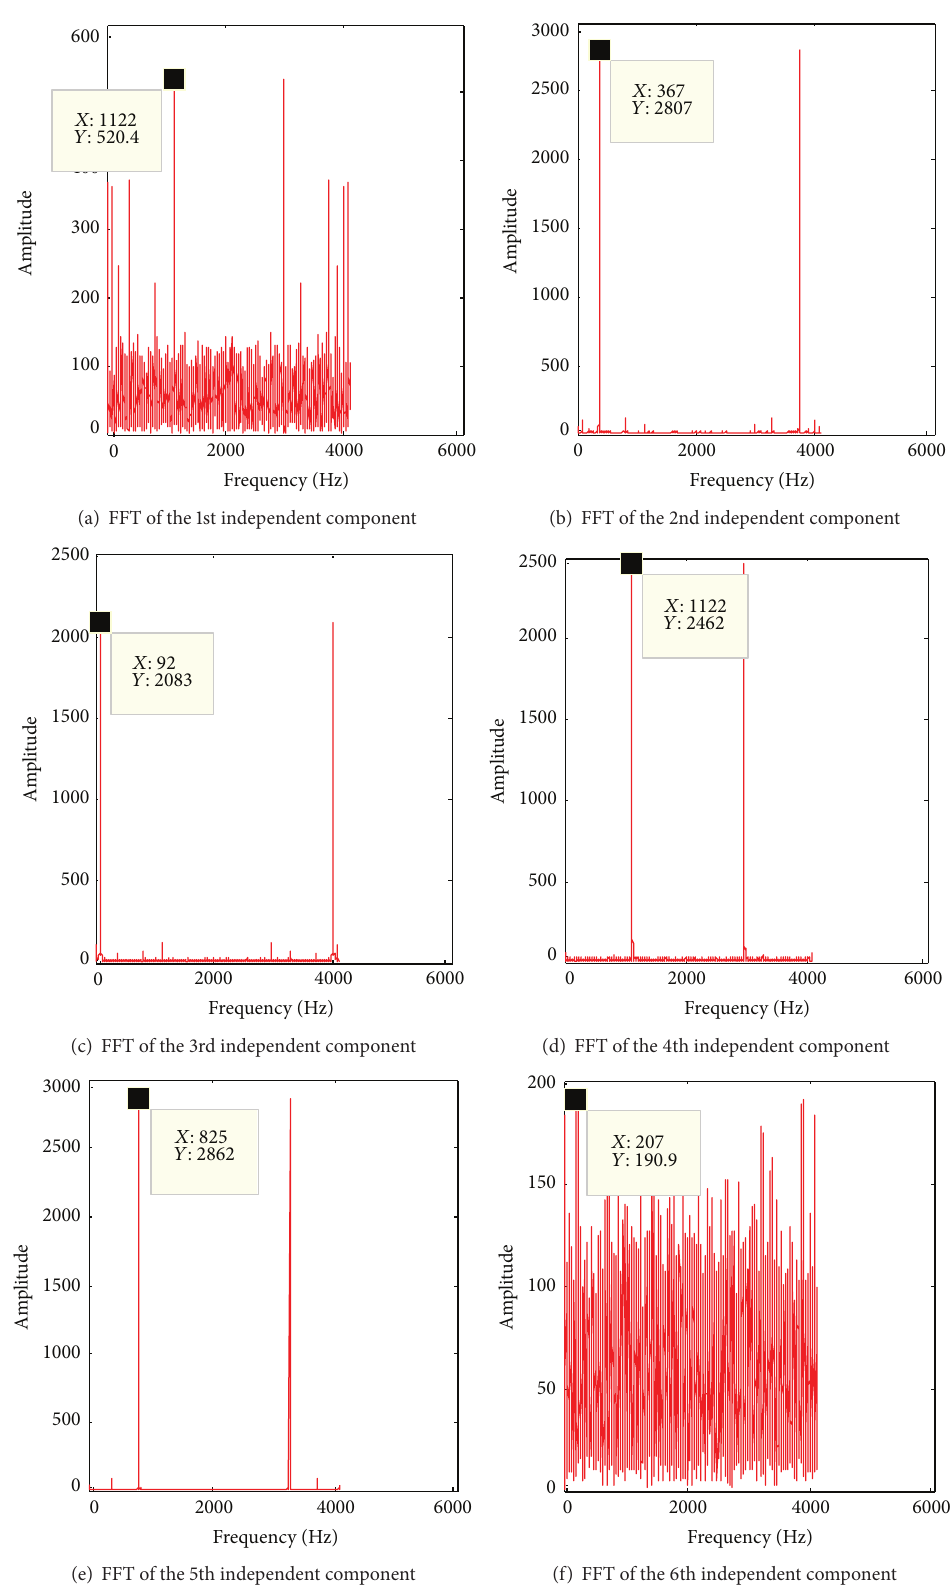
Figure 15: FFT of each independent component identified by maximization negentropy with quasi-Newton iteration method with measurement